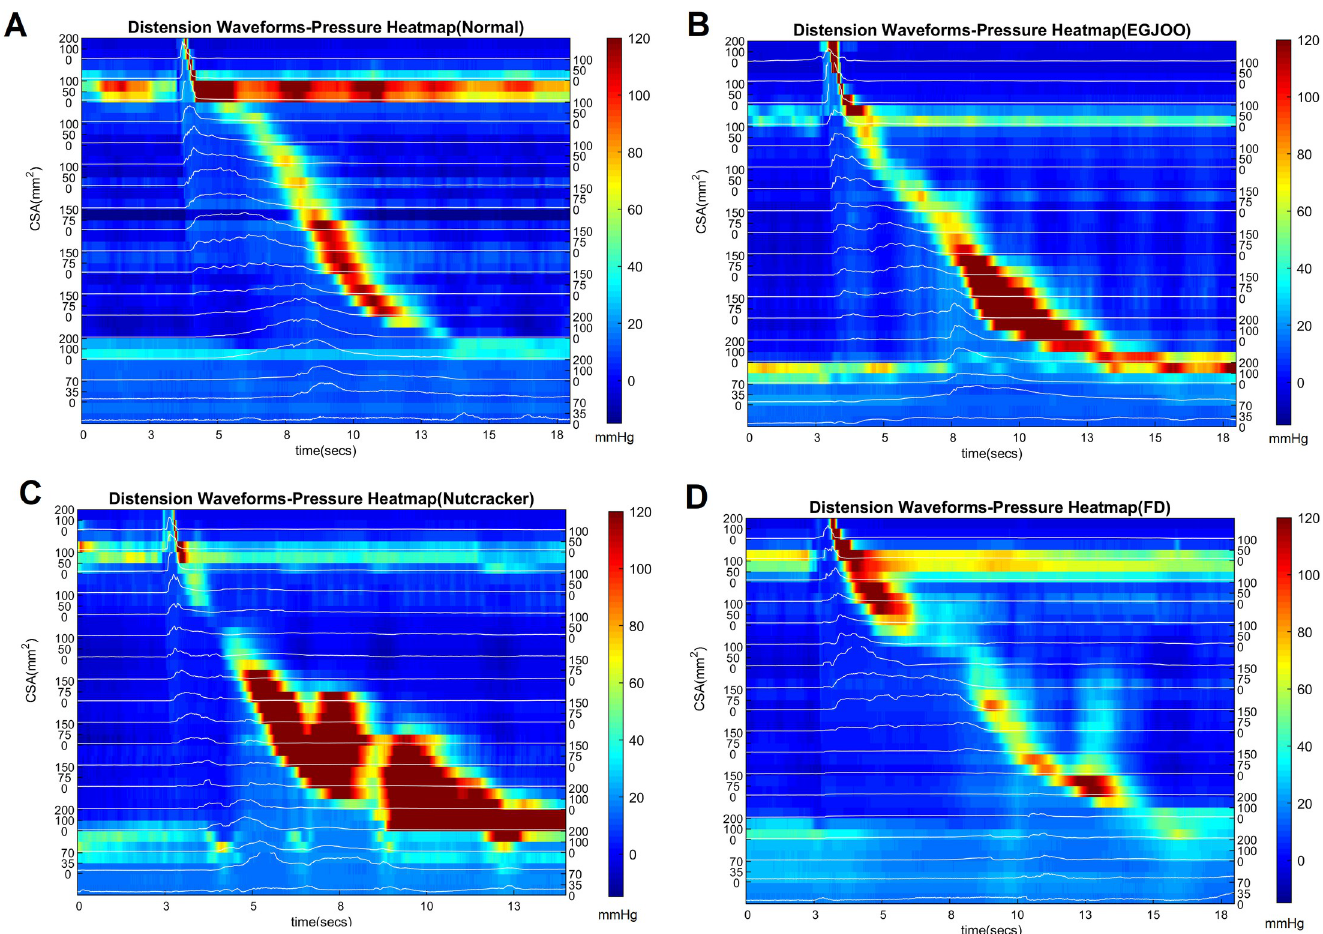
Fig 1. Pressure heatmaps of a (A) normal subject, (B) patient with esophagogastric junction outflow obstruction (EGJOO), (C) patient with nutcracker esophagus (NC), and (D) patient with functional dysphagia. Note, that the amplitude of distension in patients is smaller and there is alteration in the temporal relationship between distension and